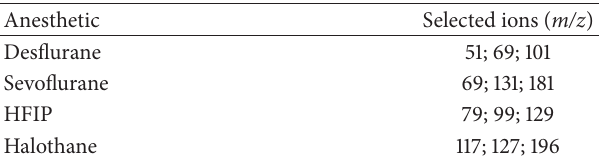
Table 1: Selected ions for SIM